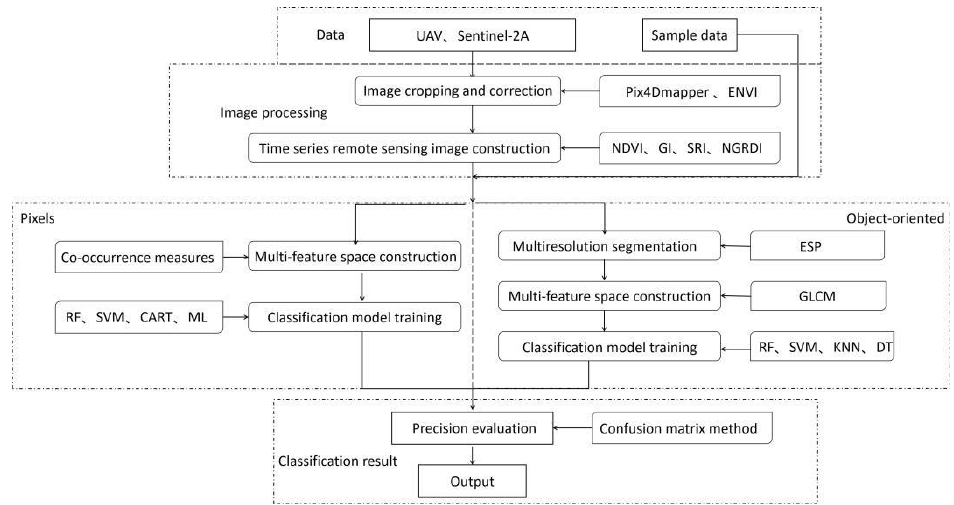
Figure 5. Technology roadmap.